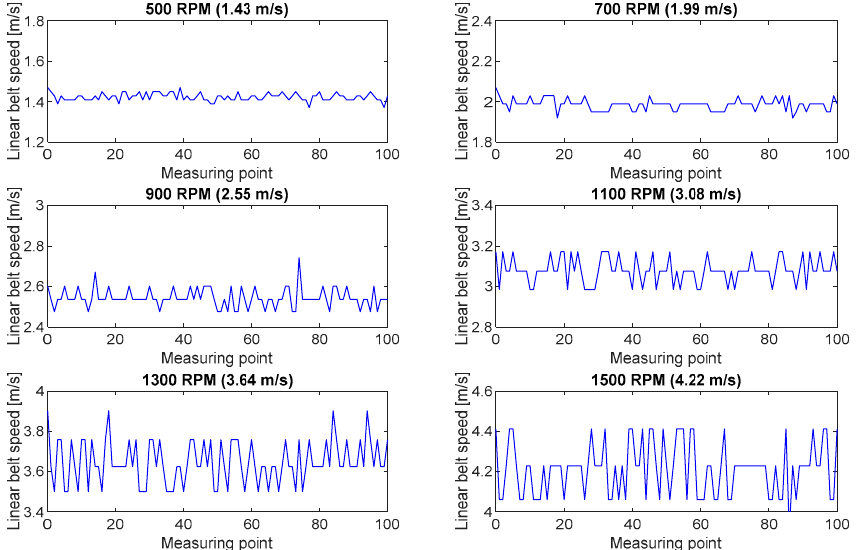
Figure 8. Fluctuations of belt linear speeds calculated in the inductive sensor measurements for six rpm ranges of the pulley motor.